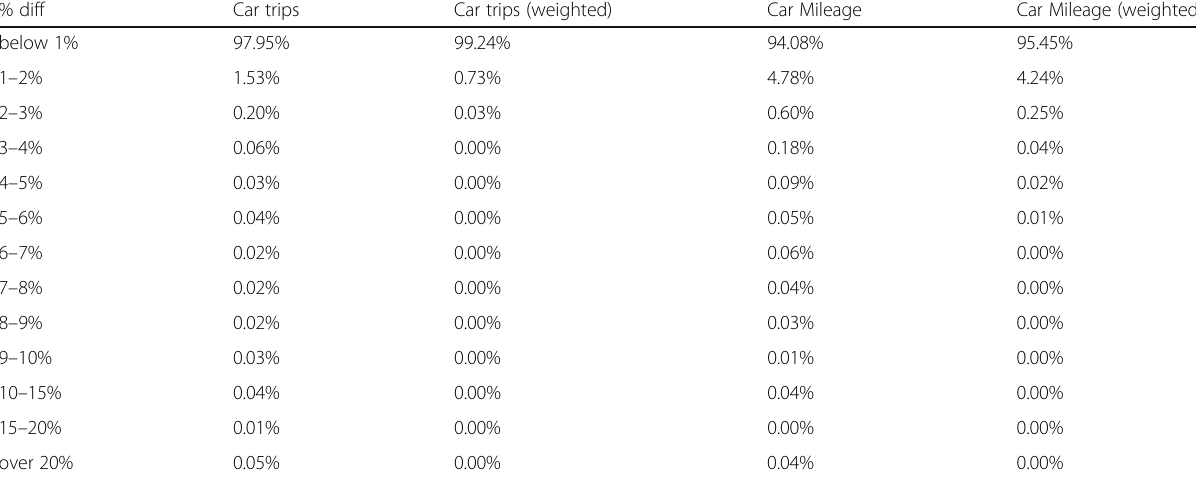
Table 12 The share of origin zones where the percentage deviation is below certain thresholds for car